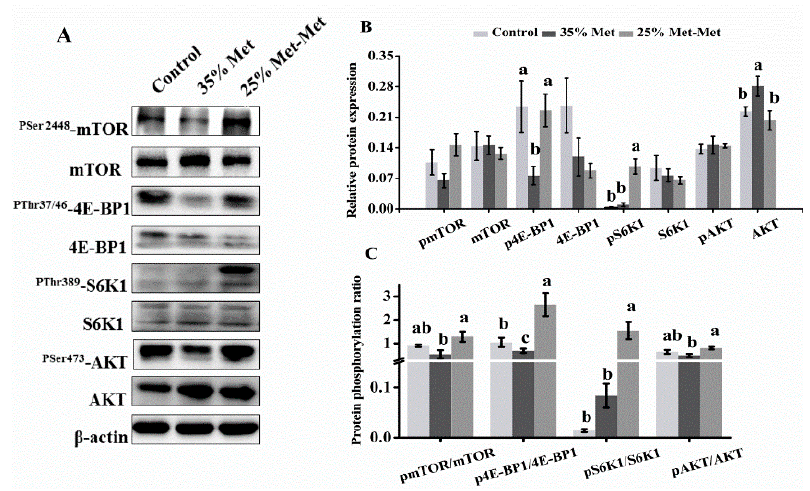
Figure 8. Expression of mTOR signaling proteins at day 17 in the placenta of mice supplemented with different sources of methionine (Met). The subfigures are representative immunoblots of the phosphorylated (P) forms and total (T) levels of the mTOR signaling proteins ( A ), the spot density analysis of the P forms and T levels of the mTOR signaling proteins ( B ), and the spot density ratio of the P:T forms of the mTOR signaling proteins ( C ). In the control group, pregnant mice were fed a diet containing free Met. In the 35% Met group, pregnant mice were fed a Met-deficient diet with intraperitoneally injection of 35% of the Met contained in the control diet. The 25% Met-Met group was treated as described for the 35% Met group, except that 25% of the injected Met was replaced with methionyl-methionine (Met-Met). The data are expressed as the mean ± SEM; three placentas were selected randomly from each group, n = 3. The different letters indicate significant differences, p < 0.05.